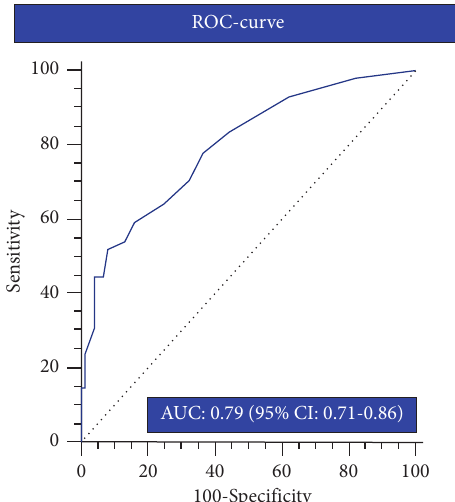
Figure 4: Diagnostic performance of residual QFR for detecting a suboptimal PCI result. ROC curve with AUC demonstrating the performance of residual QFR to predict a suboptimal PCI result defined by post-PCI FFR < 0.90. AUC, area under receiver oper- ating characteristics curve; FFR, fractional flow reserve; PCI, percutaneous coronary intervention; QFR, quantitative flow ratio; CI, confidence interval; ROC, receiver operator